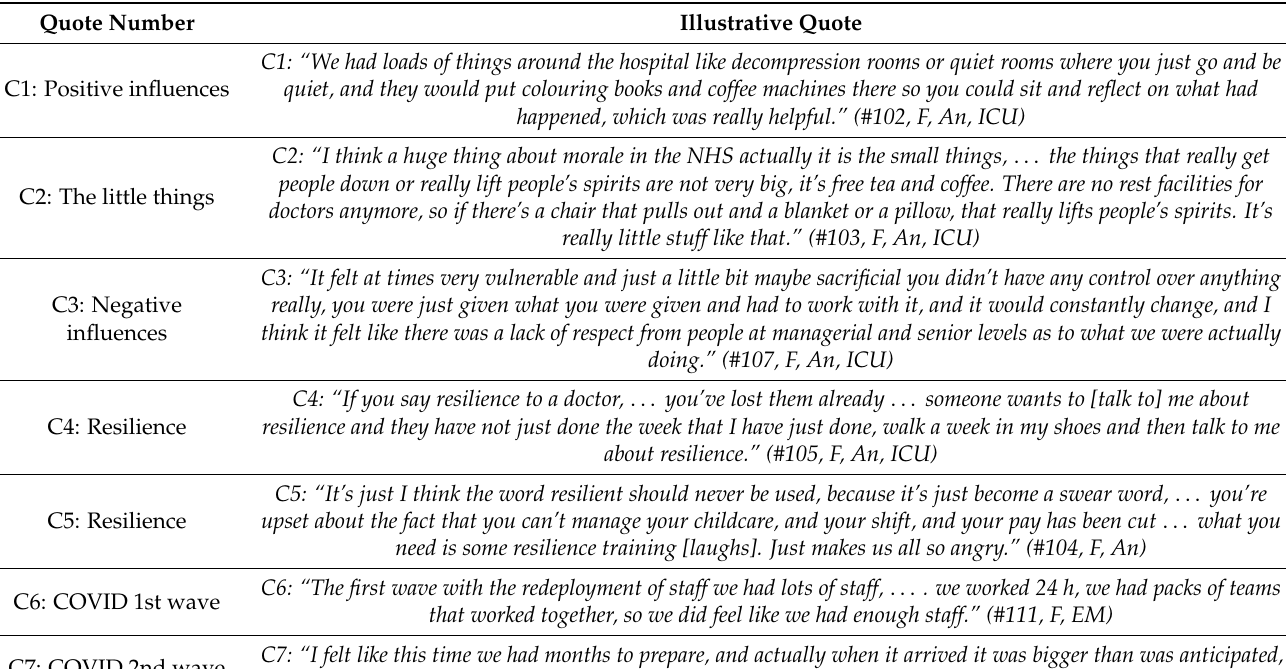
Table 6. Illustrative quotes for Organisational Influences on Wellbeing